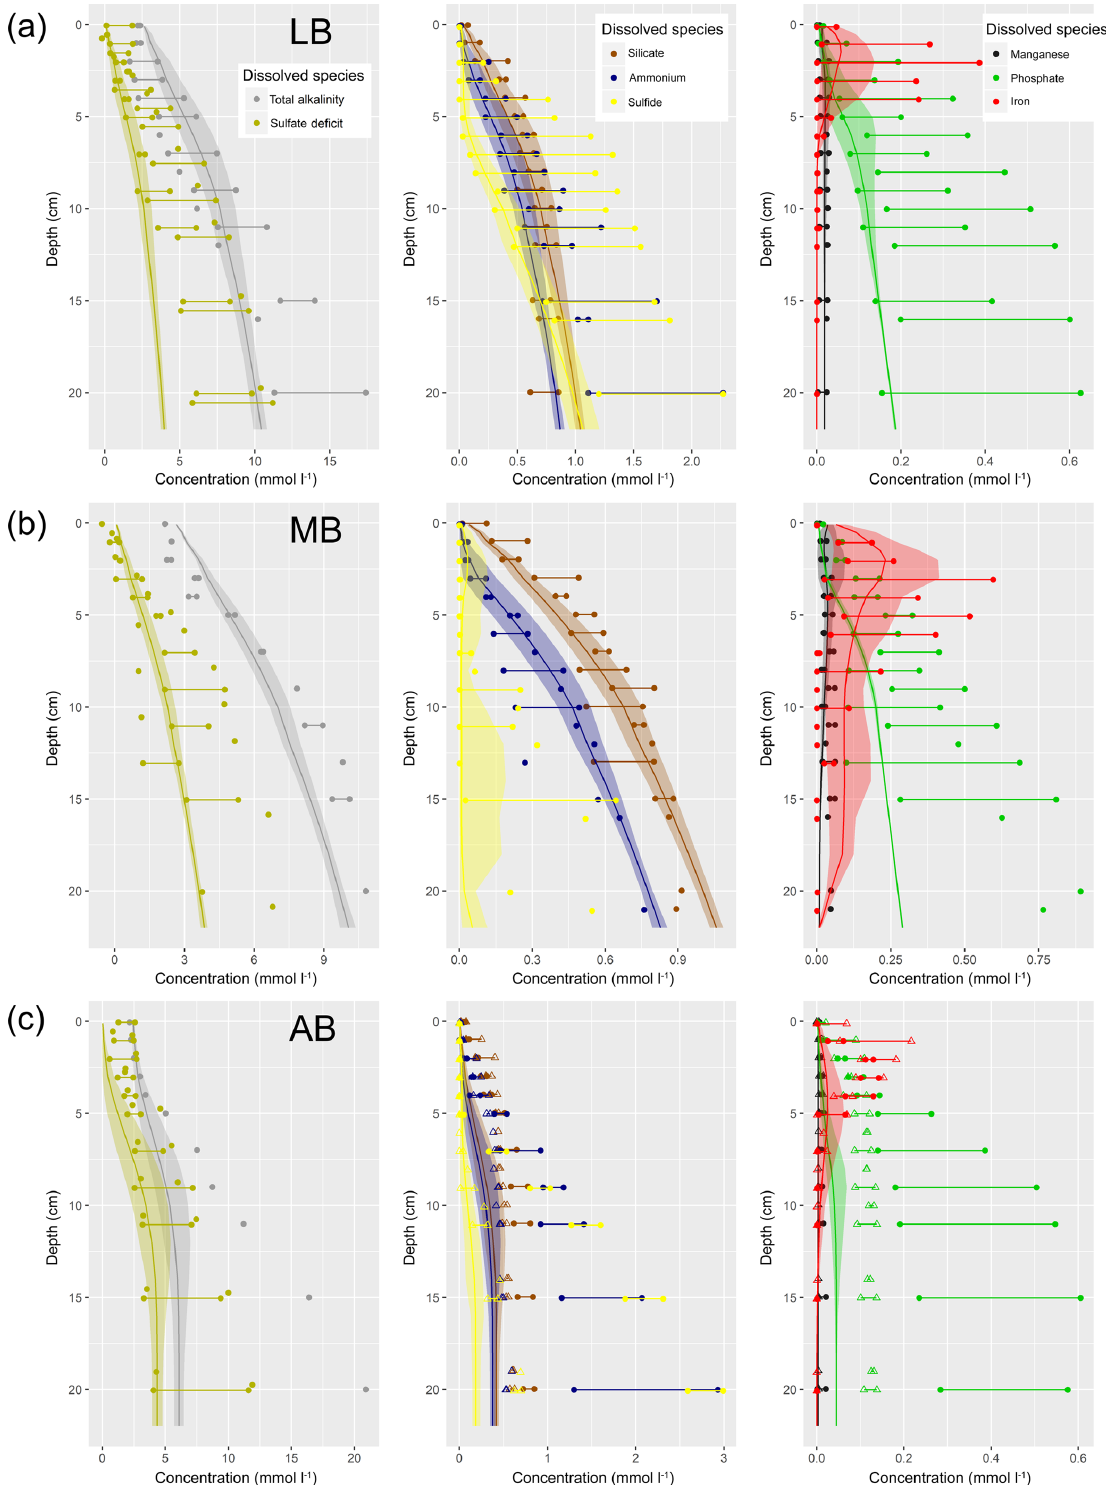
Figure 4. Pore water concentrations of several dissolved species at the three mud stations Lübeck Bight (a) , Mecklenburg Bight (b) and Arkona Basin (c) . Points and horizontal lines indicate the range of measurements. For station AB, open triangles indicate the range of observations from the January 2015 cruise, which were taken at a different location in the same area 23km apart. Curves and shading present the model results and indicate year-average concentrations and the seasonal range. Please note the different horizontal